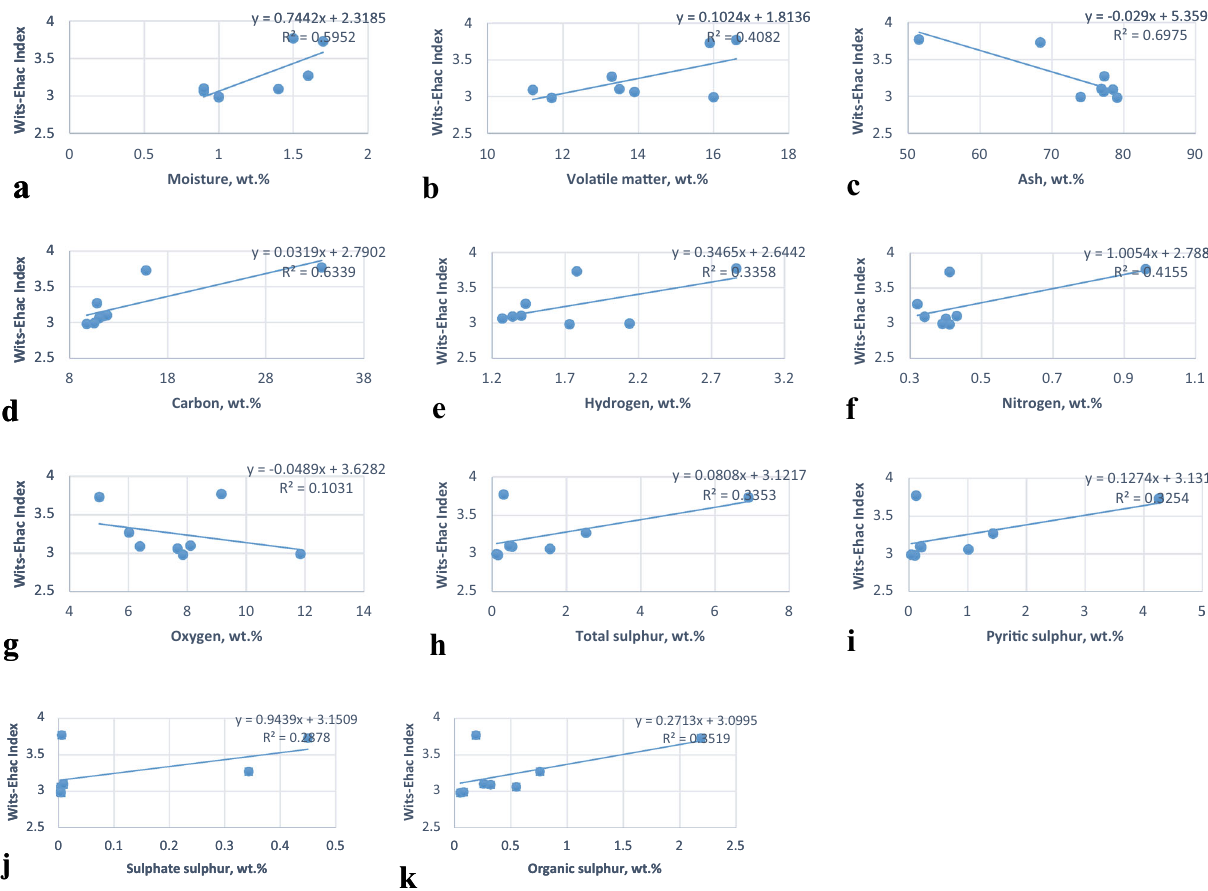
Fig. 7 Influence of proximate and ultimate analysis on spontaneous combustion liability of coal-shales